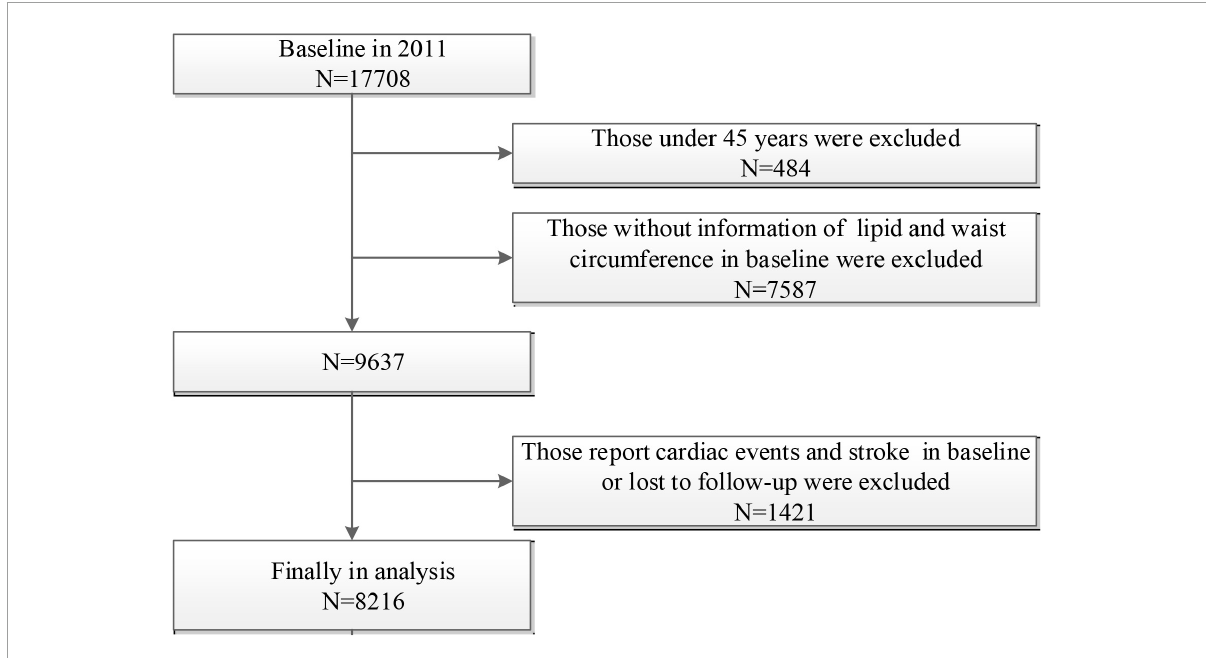
FIGURE1 Flow chart of sample selection and the exclusion criteria.